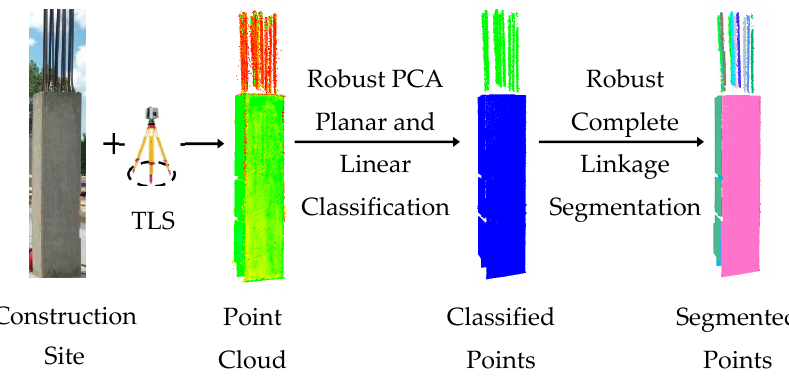
Figure 1. Automated as-built model generation scheme from unorganized TLS point cloud.